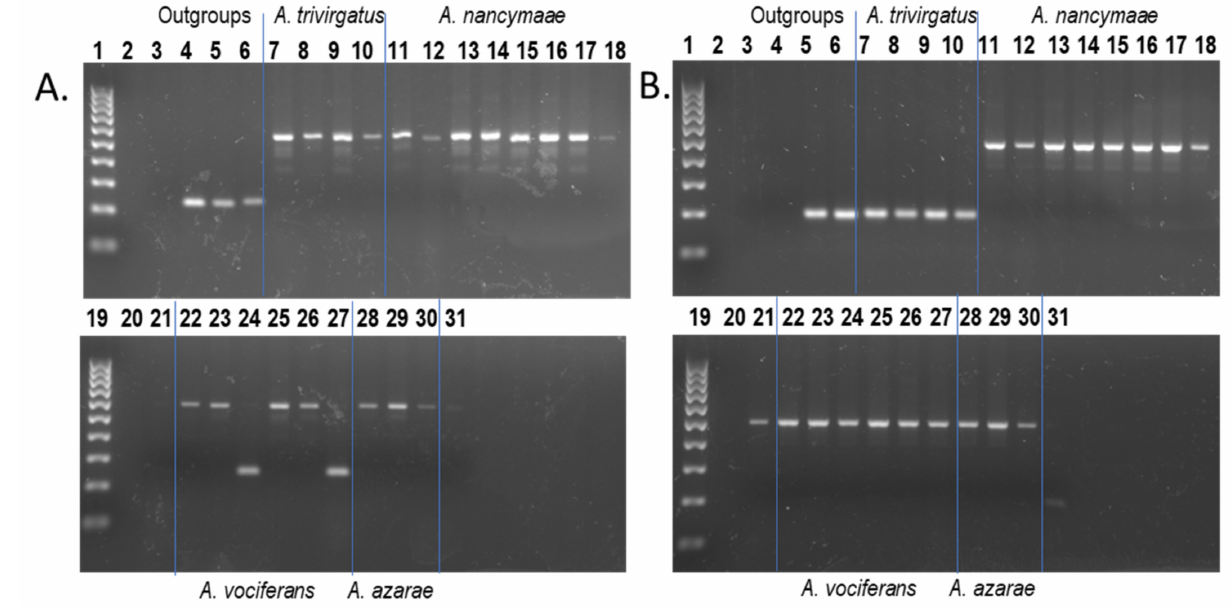
Figure 2. Aotus Alu insertion polymorphisms illustrate conflicting topologies. Lanes: 1, 19—100 bp DNA ladder; 2, 20—blank; 3-TLE (negative control); 4—Human (HeLa); 5— C. jacchus (Common marmoset); 6— S. s. sciureus (Common squirrel monkey); 7–10— A. trivirgatus ; 11–18, 21— A. nancymaae; 22–27— A. vociferans ; 28–30— A. azarae ; 31 — A. lemurinus griseimembra . ( A ) Locus Aotus _1288v2, Alu is homozygous present in all Aotus samples (~576 bp DNA fragment) with the exception of two A. vociferans individuals (~231 bp DNA fragment), lanes 24 and 27. ( B ) Locus Aotus _1602, Alu is homozygous present in all A. nancymaae, A. vociferans and A. azarae individuals (~491 bp DNA fragment) while absent in all A. trivirgatus individuals and the A. l. griseimembra sample (~188 bp DNA fragment). Blue lines superimposed on gel images visually separate species